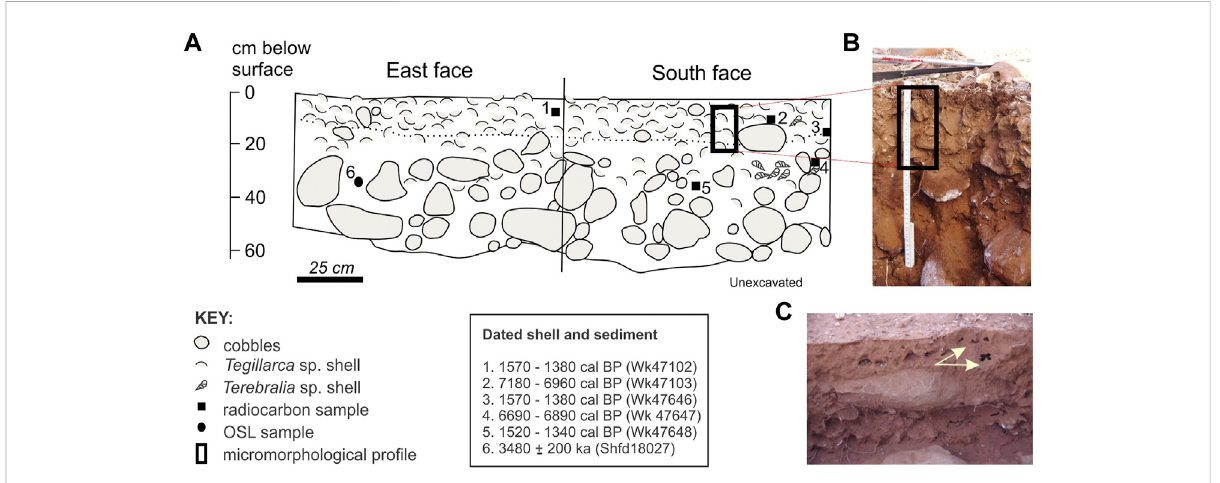
FIGURE 2 A) Section drawing of East and South face of square OG028690 showing calibrated age estimates of shell and sediment (OSL), and the approximate position of the sediment monoliths (modi fi ed from McDonald et al., 2021; their Fig. 15.5). ( B) Photograph taken after removal of